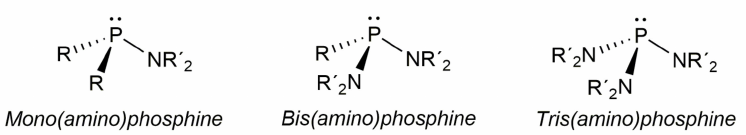
Figure 1. Generic structures of mono-, bis- and